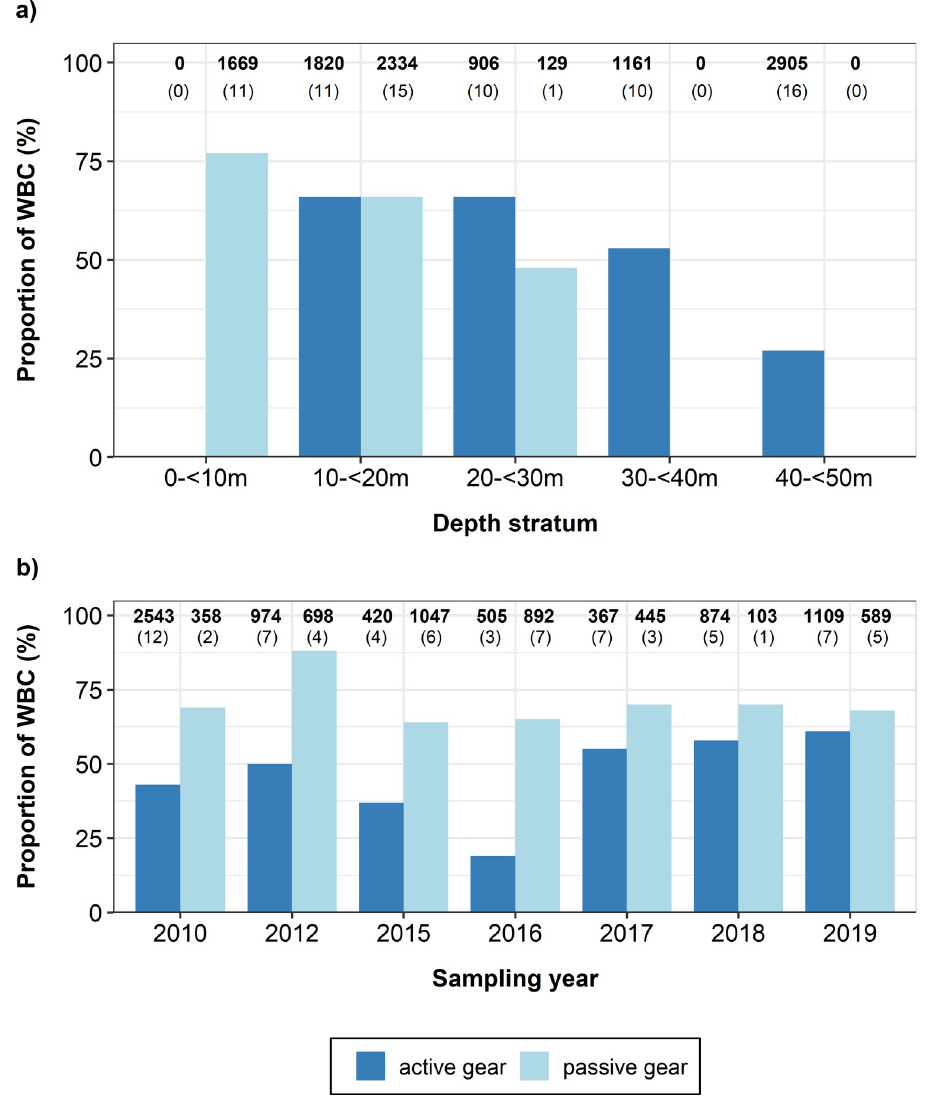
Fig 4. Fishing gear-specific proportions of WBC in SD 24. Mixing proportions are based on cod samples (N = 10 924) from German commercial catches between 2010 and 2019, using different types of fishing gears (active = trawl, passive = mainly gill net). Mixing data were grouped by a) capture depth and b) sampling year. Absolute numbers of otoliths used in the shape analysis (in bold) and total numbers of fishing hauls used in the stock mixing analysis (in brackets) are given on the top of each bar. Depths without bars = no data